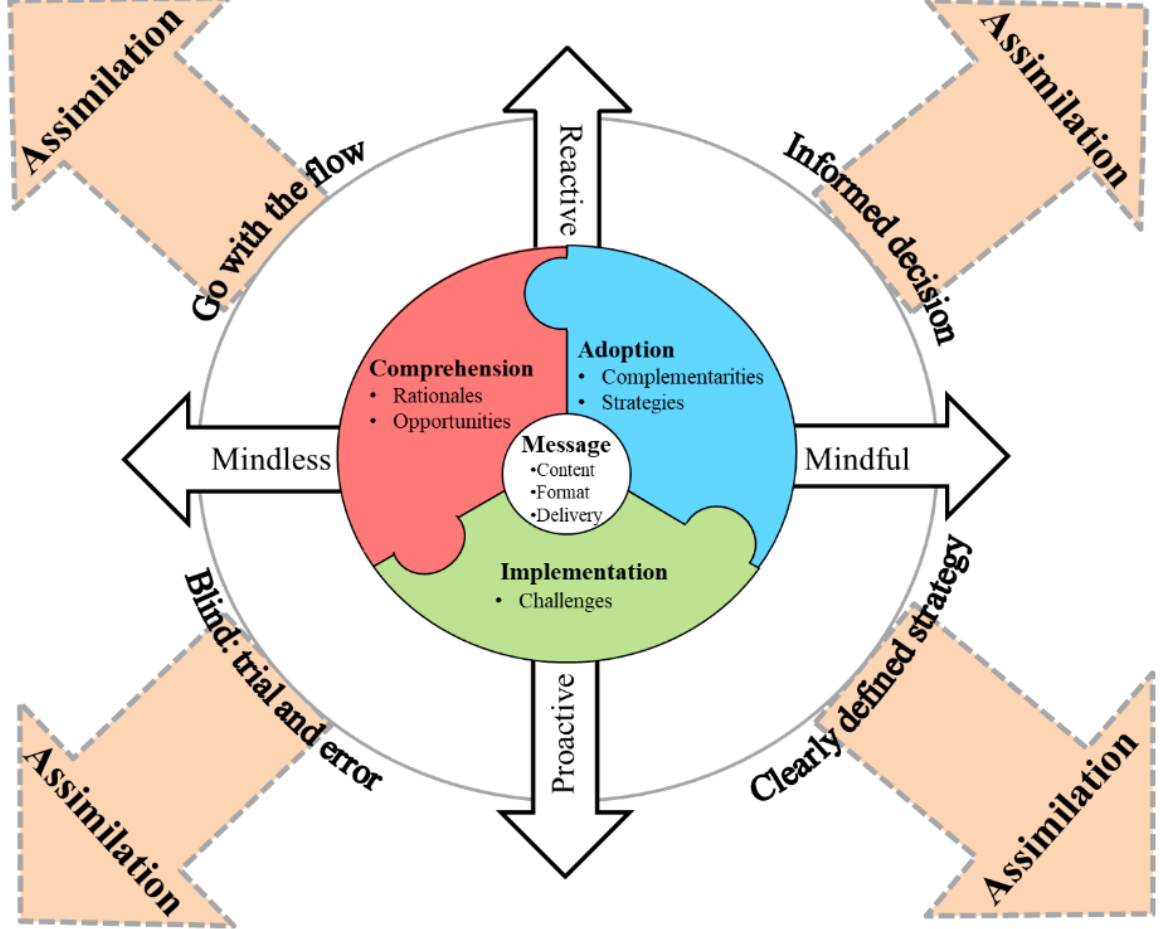
Figure 2. Process model of social media strategies for health promotion by nonprofit